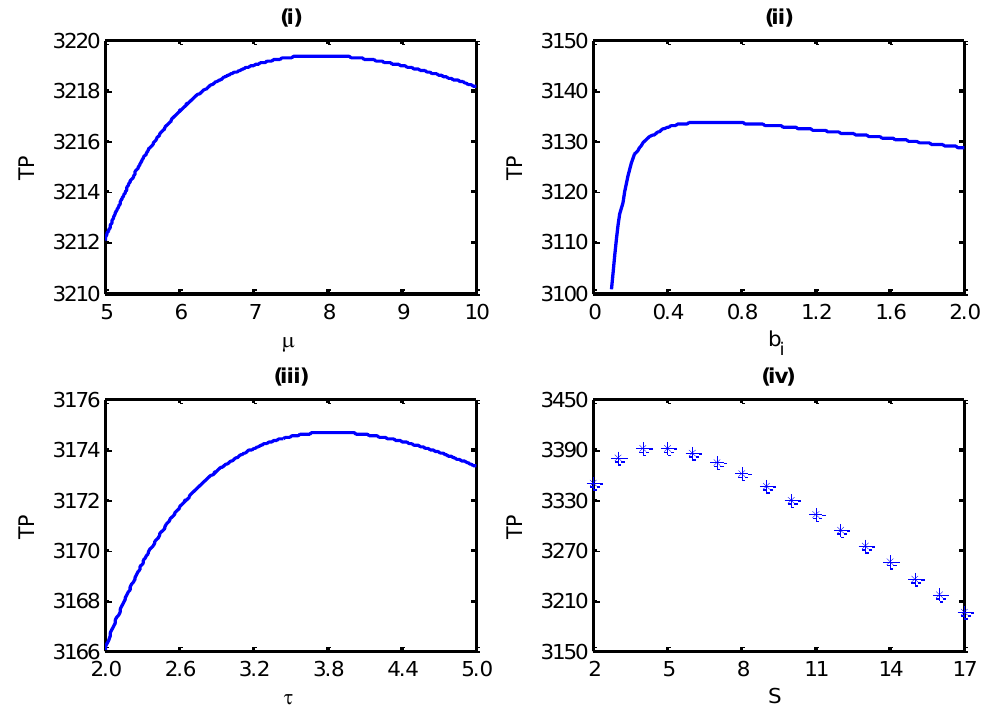
Figure 8. The concavity nature of the expected total profit function ( ) TPE wrt decision